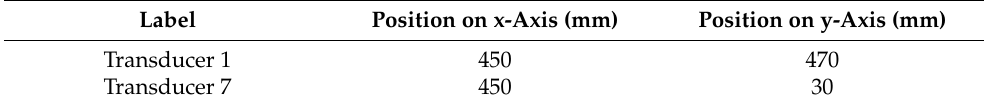
Table 7. Position of transducers 1 and 7.